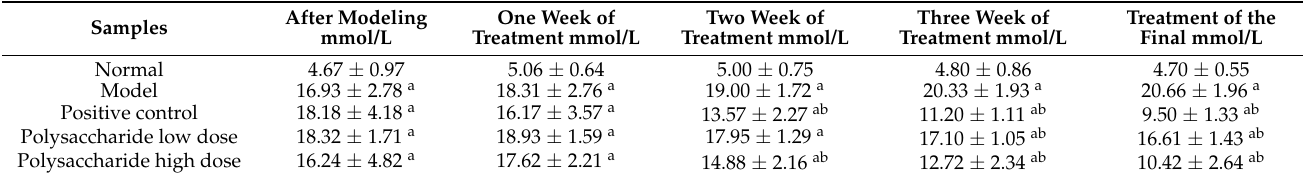
Table 3. Effects of ACP on GLU in mice.